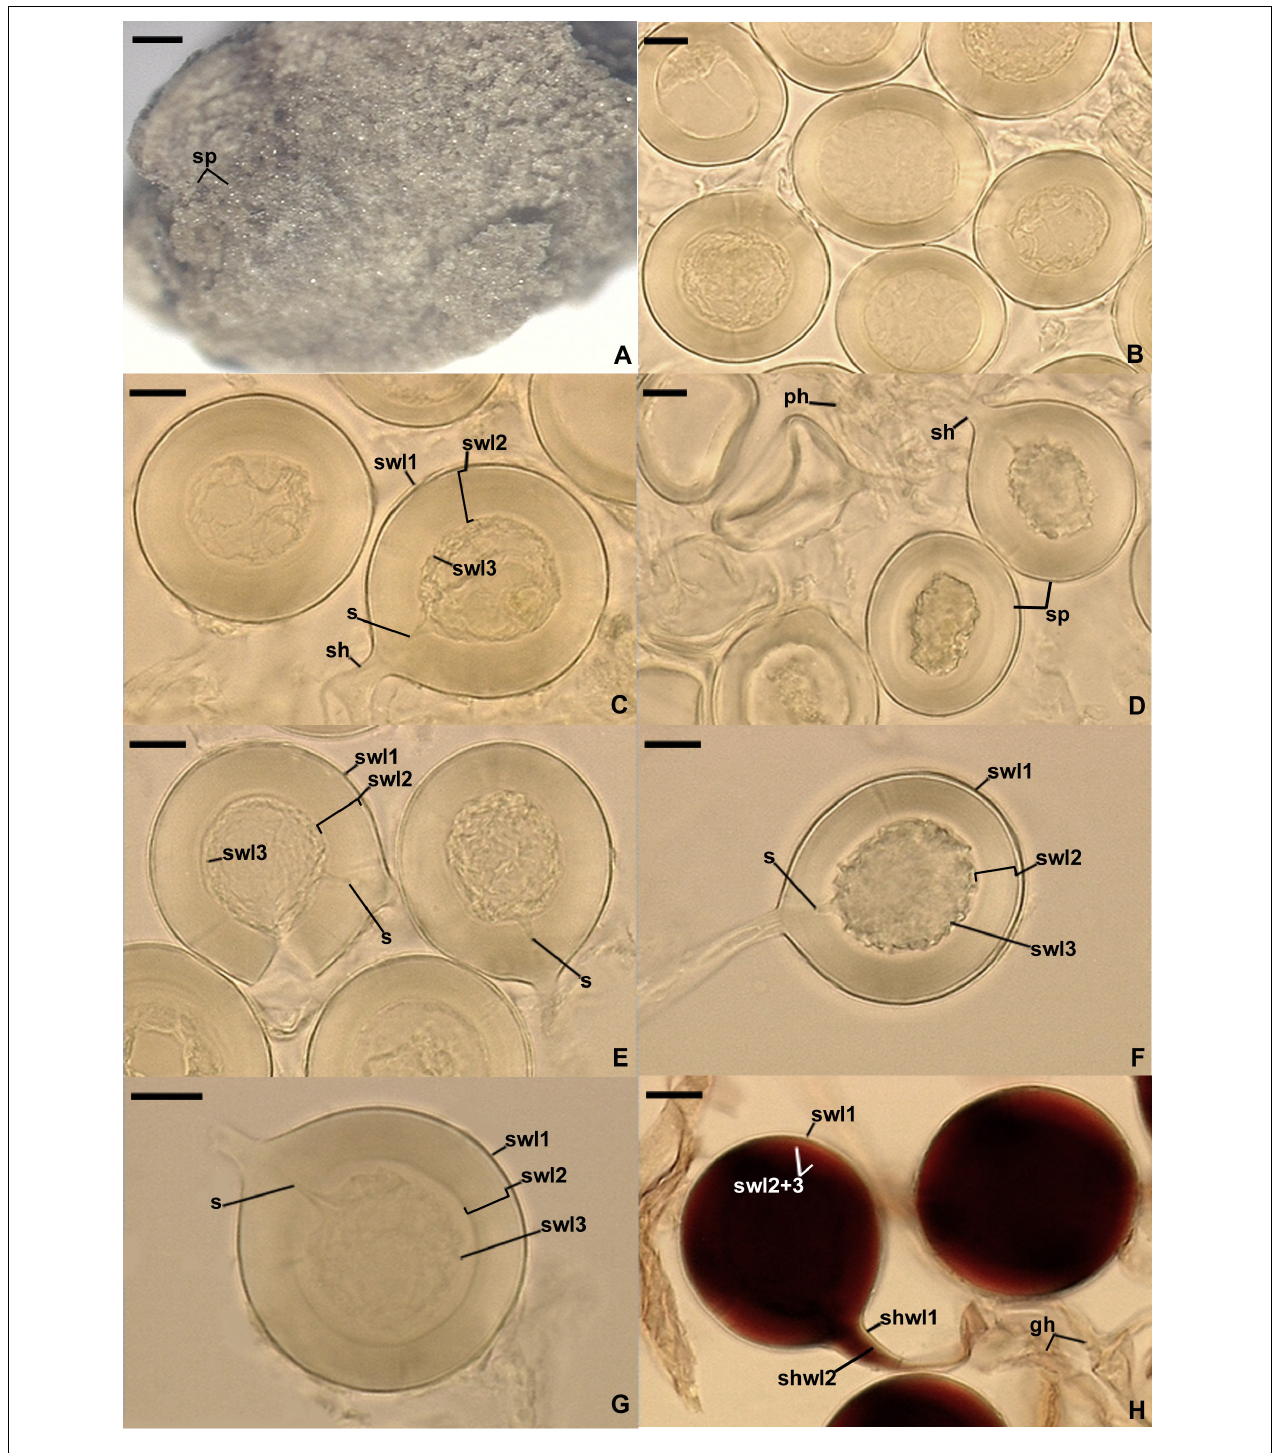
FIGURE 4 | Dominikia glomerocarpica . (A) Glomerocarp (=sporocarp) with glomerospores (=spores; sp). (B) Intact spores. (C–G) Intact and crushed spores with a three-layered spore wall (swl1–3) and a subtending hypha (sh); note that swl2 did not change in shape in crushed spores, and swl3 usually slightly contracted and separated from the lower surface of the laminate swl2 in intact and crushed spores and formed a septum (s) located at approximately half the length of the channel connecting the subtending hyphal lumen with the spore interior; peridial hyphae (ph) are visible in (D) . (H) Intact spores with swl1–3, subtending hyphal wall layers (shwl) 1 and 2, and glebal hyphae (gh) mounted in PVLG + Melzer’s reagent. (A) Dry specimen. (B–G) Spores in PVLG. (H) Spores in PVLG + Melzer’s reagent. (A) Light microscopy. (B–H) Differential interference microscopy. Scale bars: (A) = 200 µ m, (B–H) = 10 µ m.